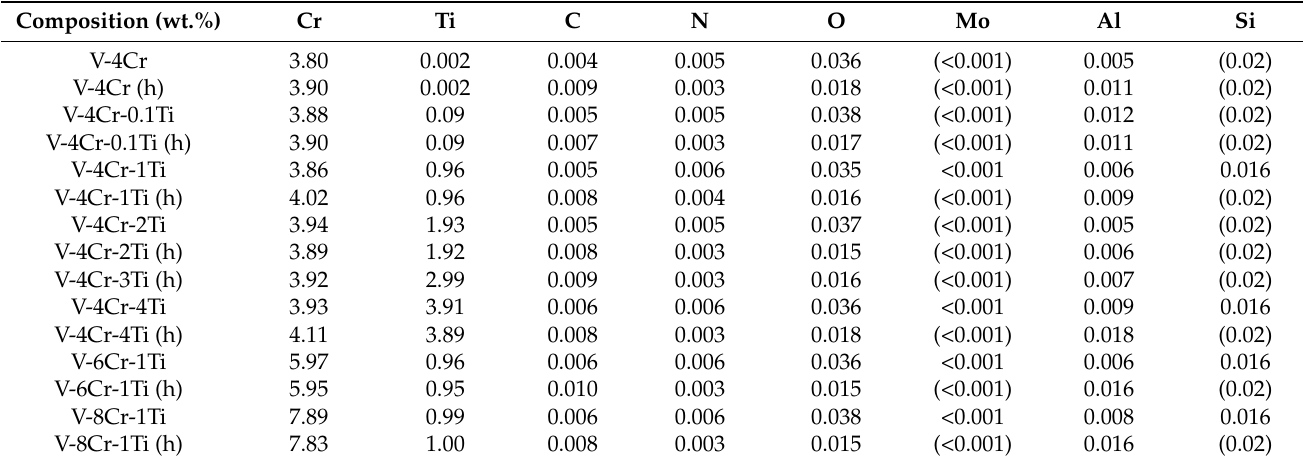
Table 1. Chemical composition of V–Cr–Ti alloys. Marks (h) indicate the type of highly purified alloy from the original alloy. Composition